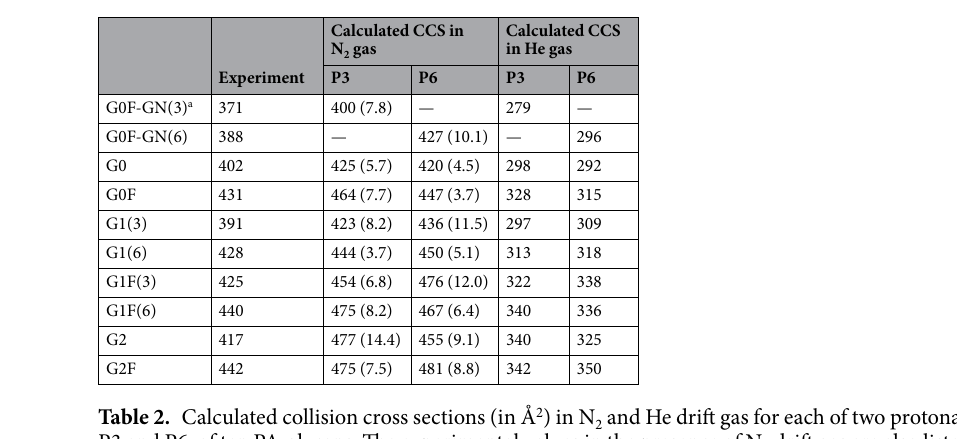
Calculated CCS. The calculated CCS values for the ten glycans in N 2 gas as well as in He gas are listed in Table 2. For both P3 and P6 states, they are plotted against experimental values in Fig. 1c. A single protonation state was considered for G0F-GN(3) (core GlcNAc protonated) and for G0F-GN(6) (see Methods for details). Calculated values coincide with experimental ones, with correlation coefficients of 0.90 (P3 state) and 0.89 (P6 state), and average percentage differences of 7.8% (P3 state) and 7.9% (P6 state), respectively (percentage differences were calculated as CCS calc − CCS exp /CCS exp × 100%). These differences could arise from inaccuracies either in simula-